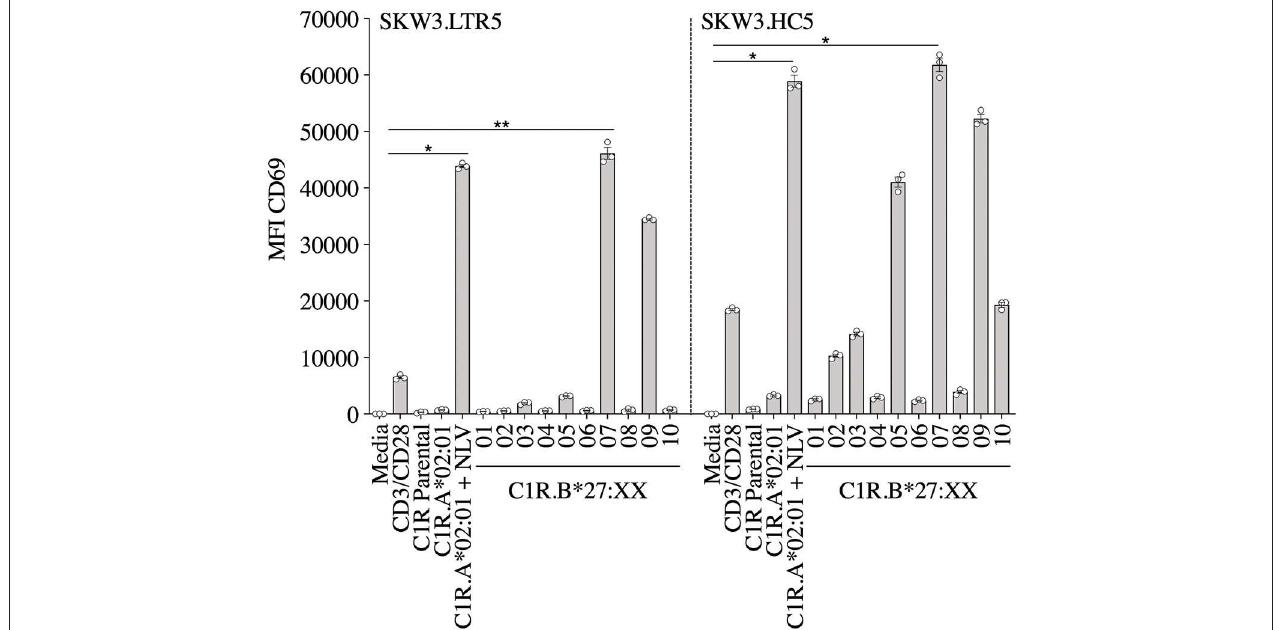
FIGURE 2 | Activation of SKW3.A2 NLV TCR cells by HLA-B27–expressing APCs. SKW3.TCR activation was measured using cell surface CD69 upregulation after 16–20h stimulation with C1R.A*02:01 ± cognate NLV peptide and a panel of C1R.B27 transfectants. CD69 MFI values were calculated after gating on FSC vs. SSC, single cells, GFP + cells, live cells, CD3 + CD8 + cells then CD69 + cells. Mean ± SEM are shown (a single experiment with triplicate data is shown from independent biological replicates performed at least twice). Statistical significance denoted by * p < 0.05 and ** p < 0. 01 was determined by repeated measures non-parametric ANOVA (Kruskal–Wallis test) with post-hoc Dunn’s multiple comparison test. TABLE 1 | Virus-specific αβ TCR signatures. Virus and TCR α -chain β HLA/epitope